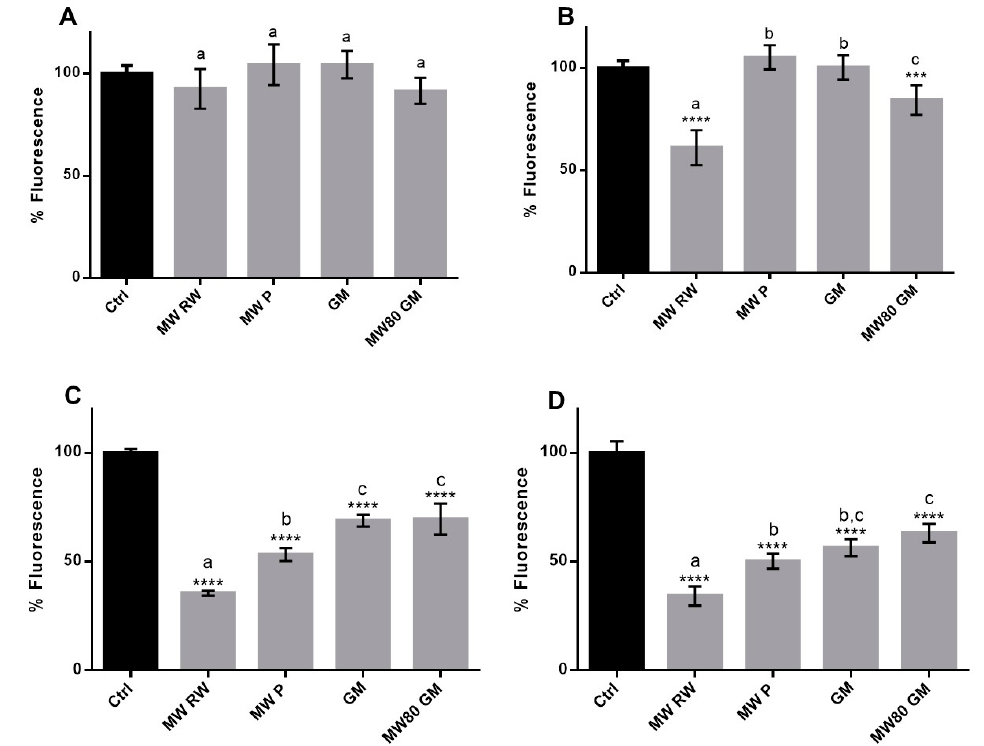
Figure 3. Pre-incubation of cells with 0.25 mg / mL of extracts for 1 h prior to addition of TBHP – e ff ect on induced ROS – in HaCaT ( A ) and HFF ( B ); co-incubation of HaCaT ( C ) and HFF ( D ) with extracts and TBHP for 1 h. The symbol * indicates significance relative to the control (*** p -value ≤ 0.001, **** p -value ≤ 0.0001). Statistical di ff erences ( p ≤ 0.05) between the samples are identified with di ff erent letters.